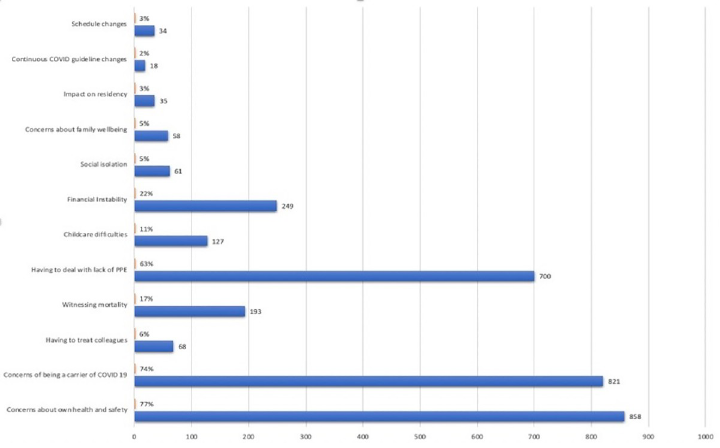
Fig 1. Major concerns of residents during the COVID-19 pandemic. (X-Axis represents the number of residents; Y-Axis represents various services offered; percentage is based on a 1115-person denominator).